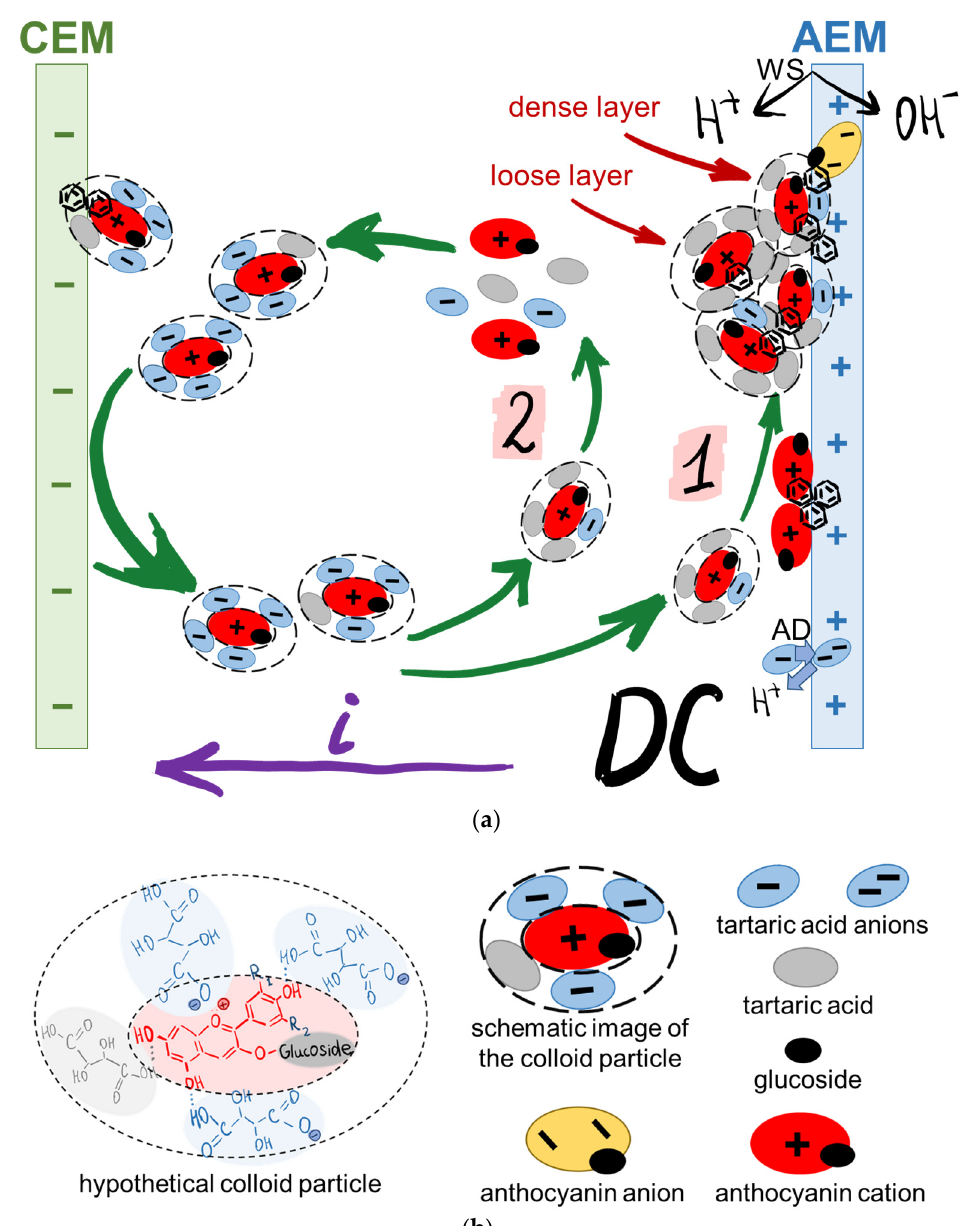
Figure 10. Hypothetical scheme of cation- and anion-exchange membranes fouling during ED of model solutions 3 and 4 ( a ), as well as the proposed structure and designation of colloid particles and other compounds ( b ). AD and WS are “acid dissociation” and water splitting mechanisms correspondingly; 1 shows a dense layer formation, 2 corresponds to a trap-mechanism formation of a loose layer.